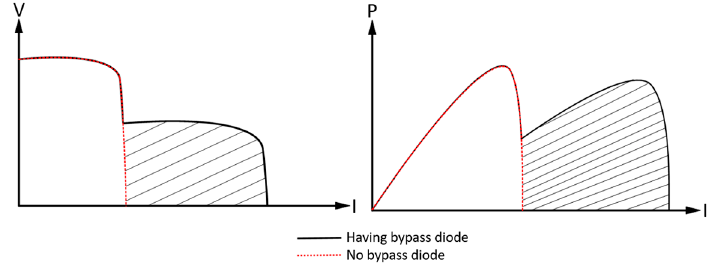
Figure 4. V-I curve and P-I curve under shading conditions.